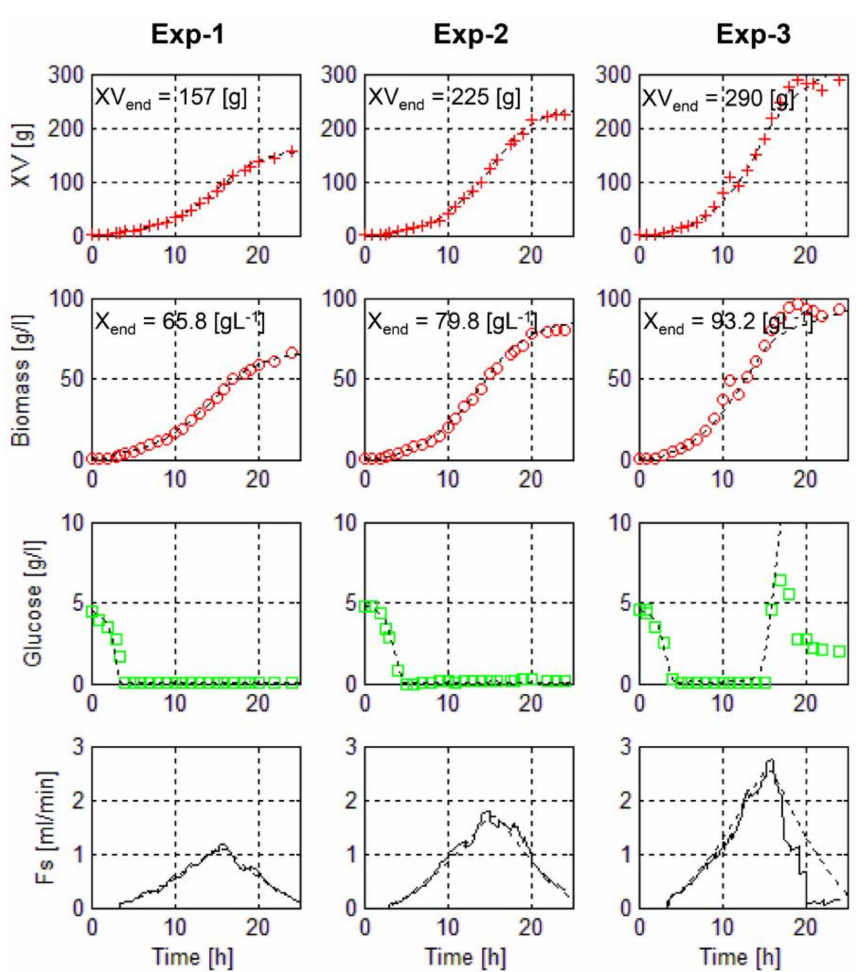
Figure 13. Cell biomass growth, substrate concentration and feed rate profiles during 3 experimental runs employing MPC feed rate control to estimate optimal MPC control parameters [99]. Dashed lines represent reference trajectories. Process productivity increases with each experiment and optimal MPC control parameters are identified after 3 runs. Figure adapted with permission from the